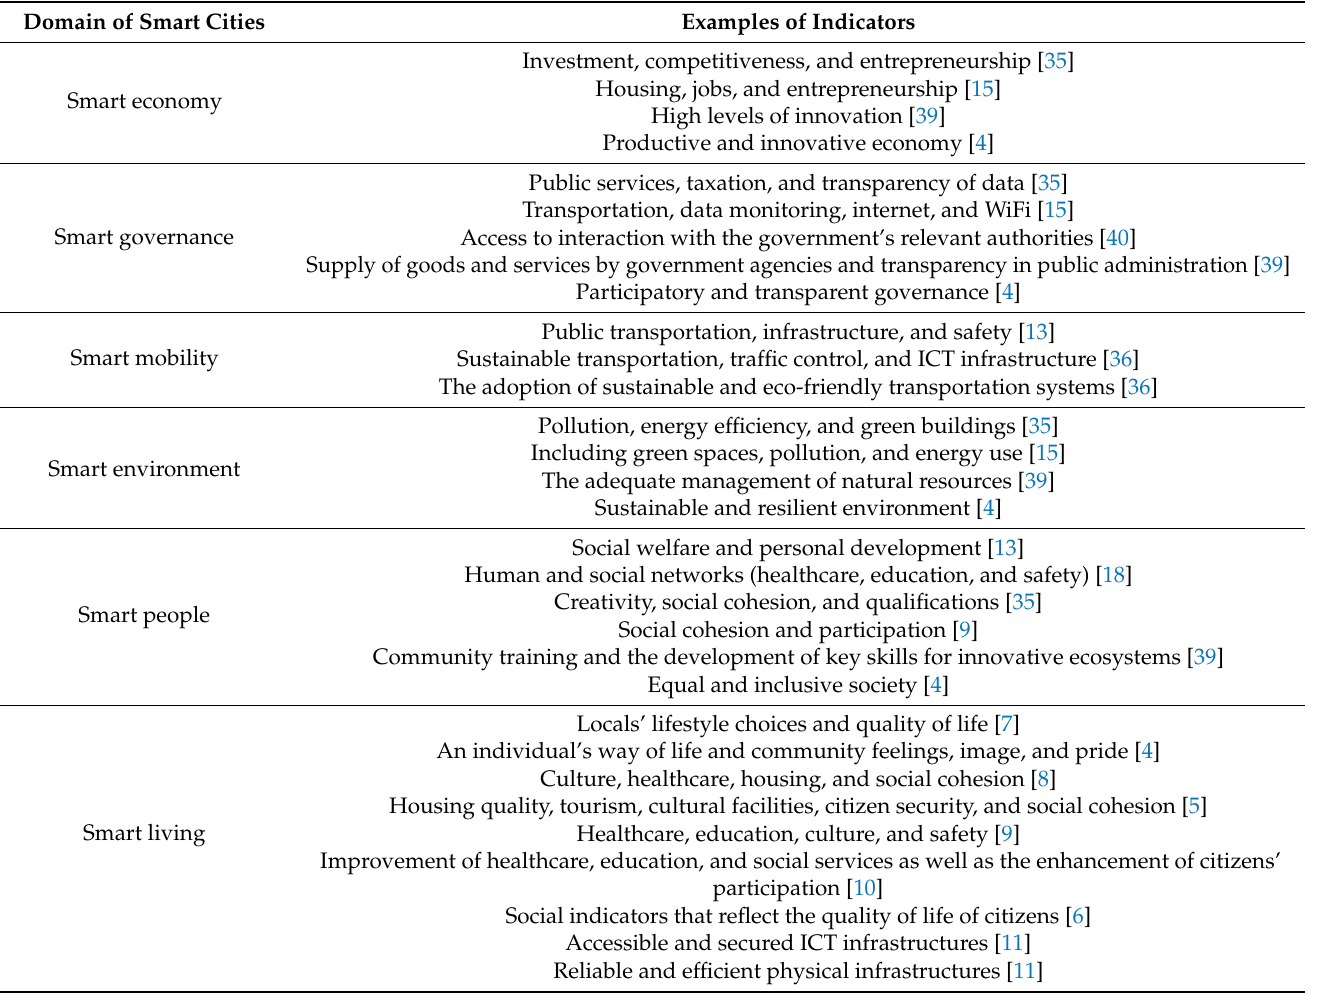
Table 4. Summary of smart city domains and indicators. Source: Authors’ own